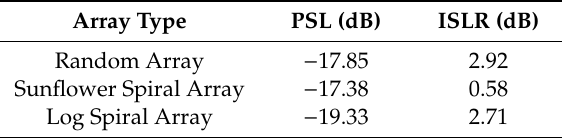
Figure 3. ( a , d , g ) illustrate the layout of the optimised random array, sunflower array and log spiral array separately. The corresponding unsteered directivity functions are illustrated in ( b , e , h ). ( c , f , i ) show the steered beam profile ( 10° ) for each array configuration. Table 2. PSL and ISLR for each optimised